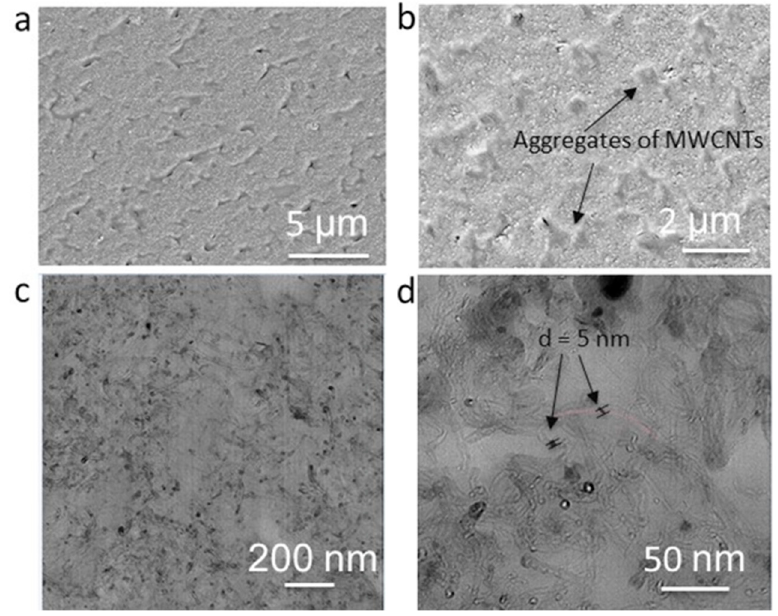
Figure 4. ( a , b ) Backscattered SEM images of the PEU70PLA30MWCNT14 and ( c , d ) TEM analysis of the composite.